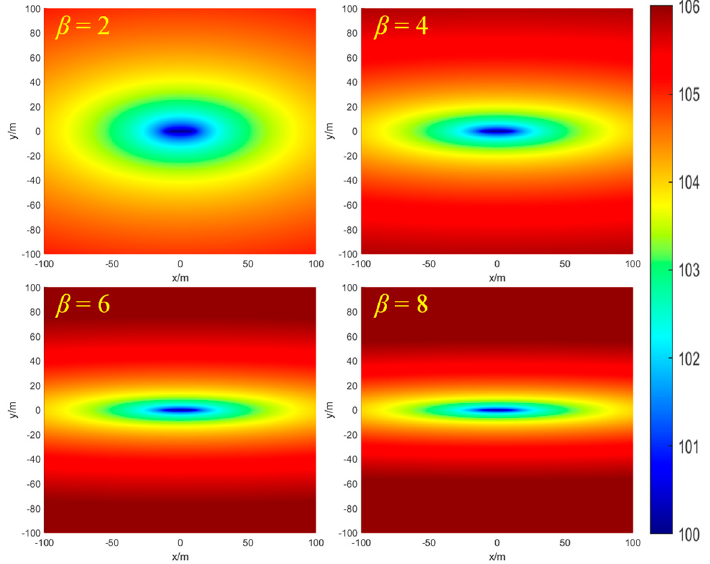
Figure 8. Pressure field distribution of heterogeneous coal seam under fracturing.